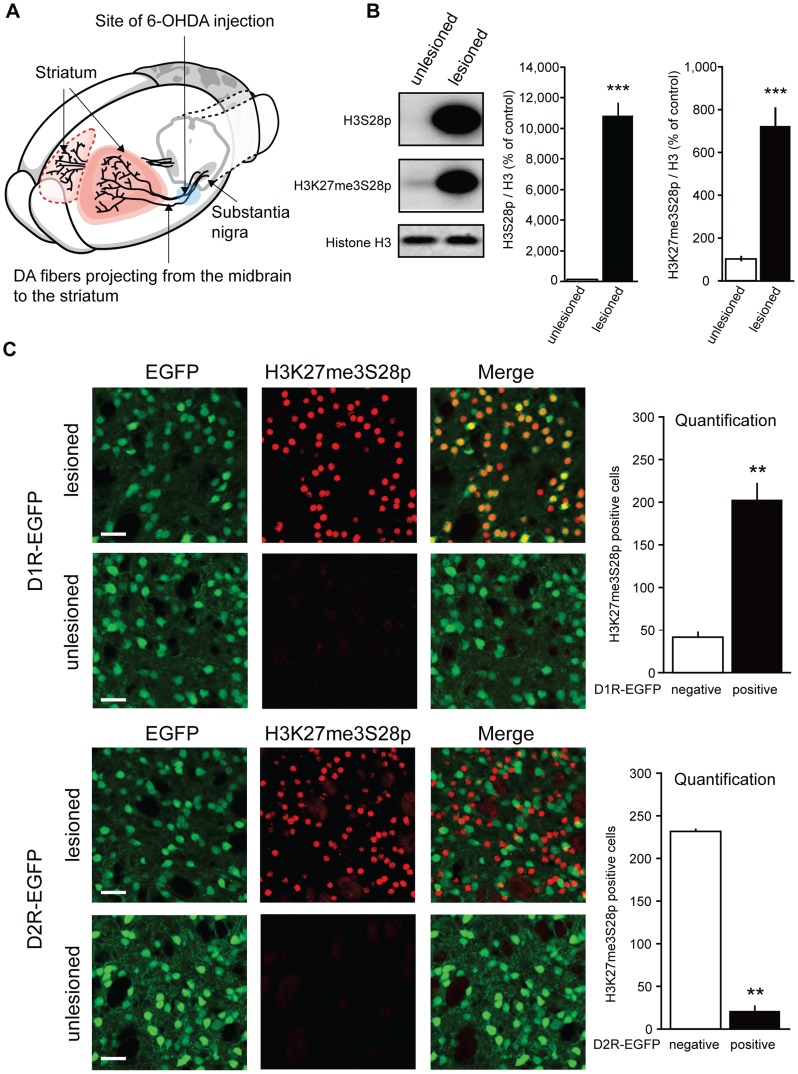
L-DOPA triggers H3K27me3S28 phosphorylation in MSNs of hemiparkinsonian mice.A) Hemiparkinsonian mice were generated by unilateral injection of 6-OHDA into the medial forebrain bundle, eliminating the dopaminergic (DA)-innervation from the substantia nigra into the striatum. B) Acute L-DOPA administration (1 hour) increased H3S28p and H3K27me3S28p in the lesioned striatum shown by Western blotting. Mean values ±S.E.M in the bar diagrams, *** p<0.001, n = 3–6 per condition. C) Confocal micrographs of H3K27me3S28p immunostaining from the striatum of D1- or D2-receptor EGFP-expressing mice. Acute L-DOPA administration increased H3K27me3S28p which predominantly co-localized with EGFP-labeled cells of D1R-EGFP mice (t(4) = 8.20, ** p<0.01) and which segregated from EGFP-labeled cell bodies of D2R-EGFP mice (t(2) = 30.30, ** p<0.01). n = 2–3 per condition. Quantifications are means ±S.E.M. Scale bar is 30 µm.